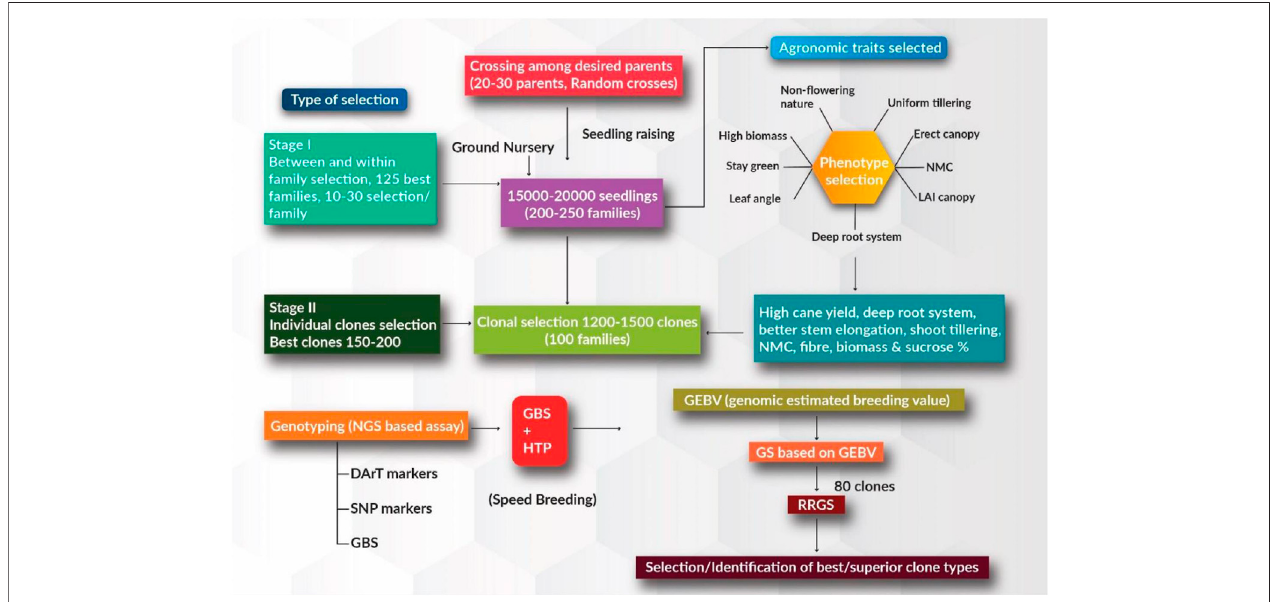
FIGURE 1 | Schematic for genomic selection (GS) approach in sugarcane for increasing the rate of genetic gain and reducing generation intervals. Stage 1representsthetraining population wherephenotypicselectioniscarried outbased ondesirablemajor agronomicaltraits.Stage2representsindividual clonalselection where the best clones are selected, and genomic estimated breeding value (GEBV) estimation is